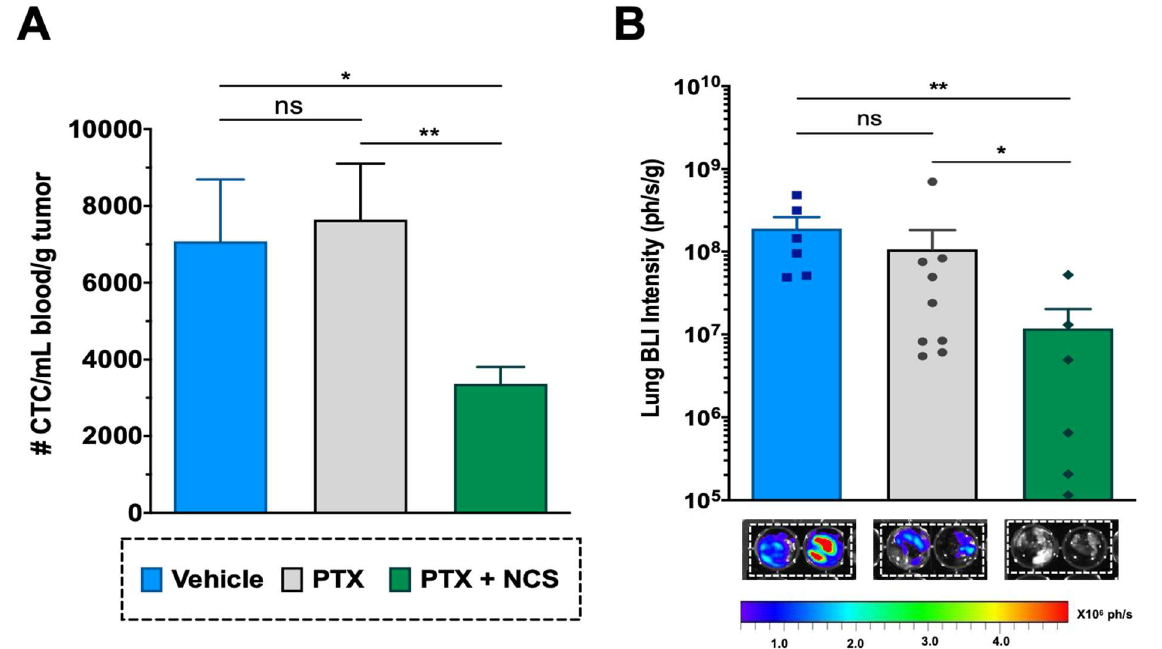
Figure 10. Effect of the PTX-NCS combination on CTC and lung metastasis. ( A ) Quantification of plasma circulating tumor cells (CTCs) isolated from the bloodstream of MDA-MB-231 tumor-bearing mice and further analyzed by flow cytometry. The results are represented as the number of CTC events (mean ± SEM) per mL of blood collected and further normalized per gram of tumor (n ≥ 6). A statistic t -test analysis was performed to compare the results between the study groups. ( B ) Quantification of BLI signal intensity from mice lungs of all three study groups. Results are expressed as the mean ± SEM of the BLI signal (ph/s) per gram of lung tissue (n ≥ 6). Statistical Mann–Whitney analysis was performed comparing the results between the study groups. Representative BLI images of excised mice lungs from all three study groups at endpoint necropsy are also shown. Bioluminescent signals were analyzed by ex vivo imaging using the IVIS Spectrum and further quantified using Living Image ® 4.5.2 software. Statistical significance is shown as ns p > 0.05, * p < 0.05, and ** p < 0.01.